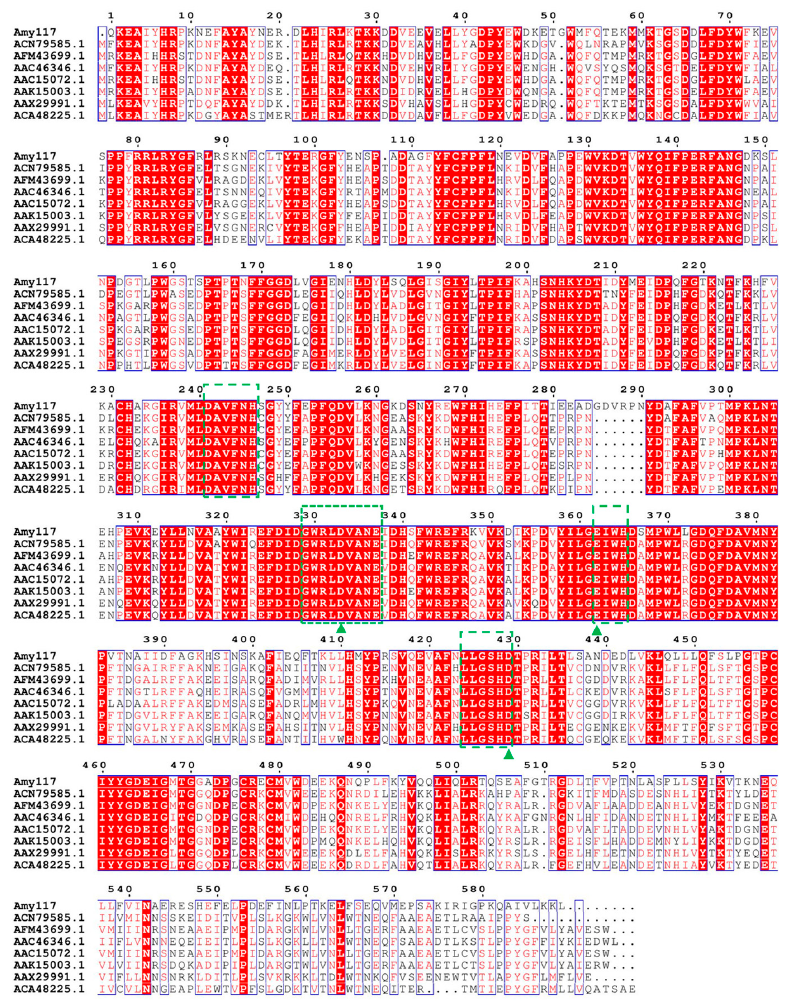
Figure 1. Sequence alignment of Amy17 from B. pseudofirmus 703 with some other bacterial α -amylases. The catalytic triads (DED) are marked with triangles, and four sequences conserved among enzymes belonging to the GH13 family are marked by green boxes.